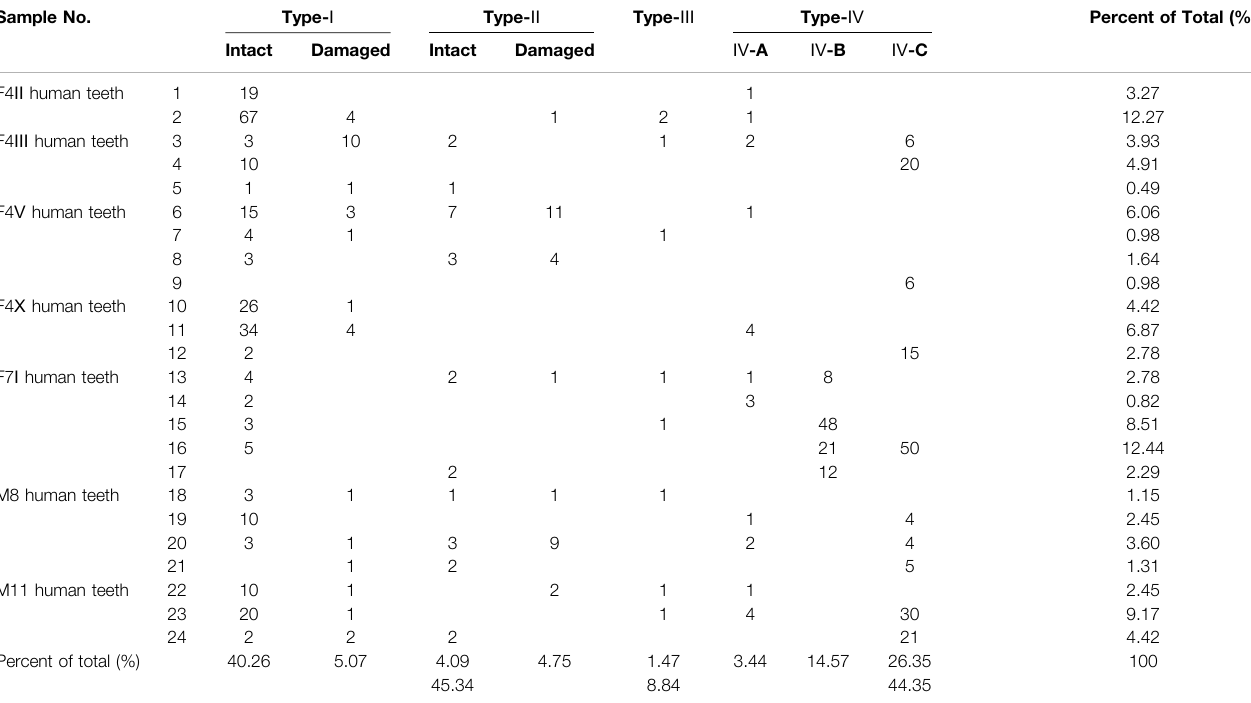
TABLE 2 | Classi fi cation, quantity and percentage statistics of starch grains from human dental calculus at the Lajia site. Sample